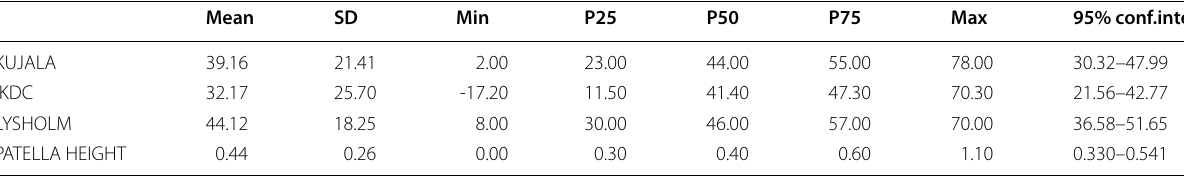
Table 1 Results from pre-operative to final follow-up at 12 months of the different scores used, and the pre- and post-surgery patellar height. (SD standard deviation; Conf.inter. =